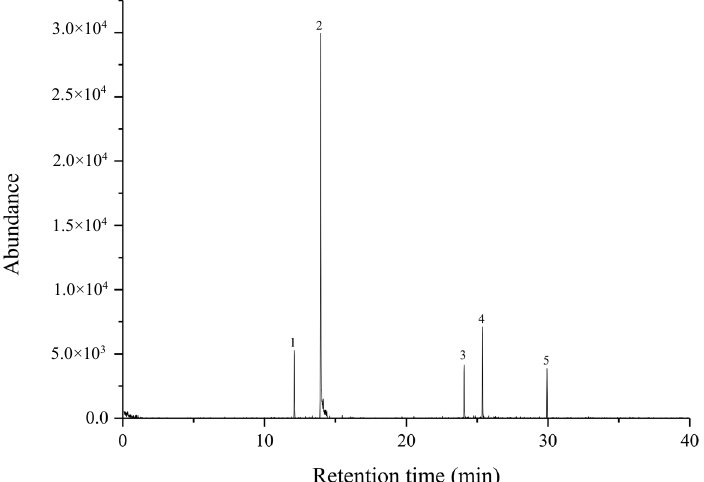
Figure 8. Total ion chromatogram of aging-related body odor spiked on 100% cotton T-shirt using INME method ((1) trans -2-nonenal, (2) benzothiazole, (3) hexyl salicylate, (4) a-hexyl cinnamaldehyde, and (5) isopropyl palmitate).